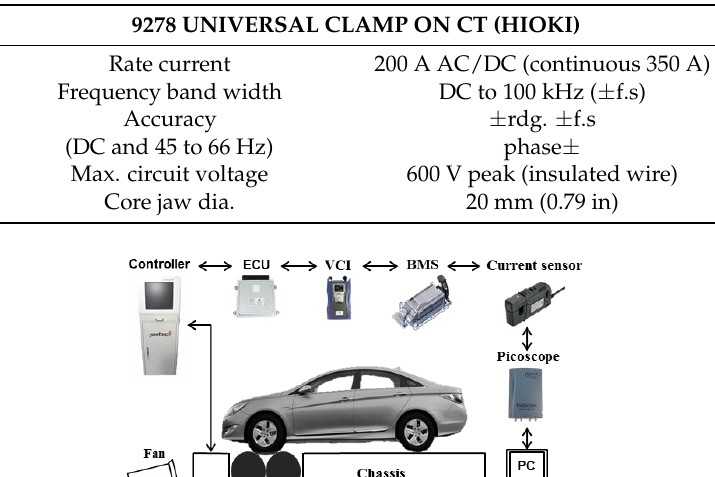
Figure 2. Data acquisition devices for measuring power signal of HEV. Table 2. Specifications of Clamp Current Sensor.